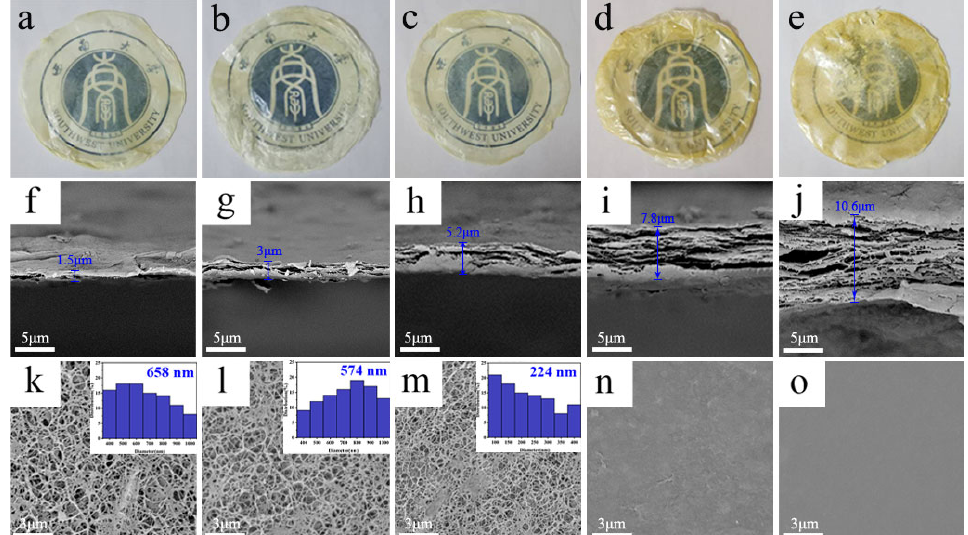
Figure 3. ( a – e ) Digital photographs, ( f – j ) cross section and ( k – o ) surface morphologies of the ANF films prepared by different amounts of the ANF dispersion: ( a , f , k ) 5 mL; ( b , g , l ) 10 mL; ( c , h , m ) 20 mL; ( d , i , b ) 40 mL and ( e , j , o ) 80 mL. The insets of Figure 3k–m show the pore size distribution of the